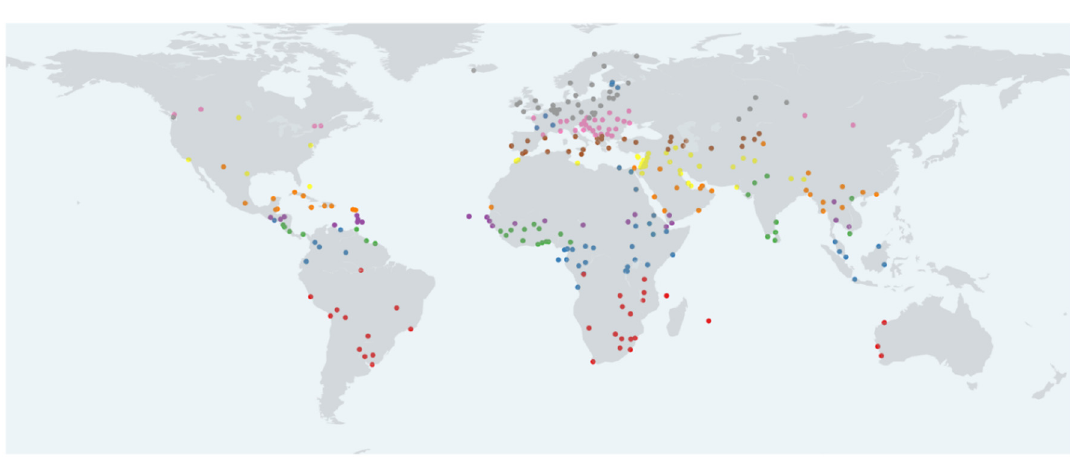
Figure 1. The places where the training data are collected.